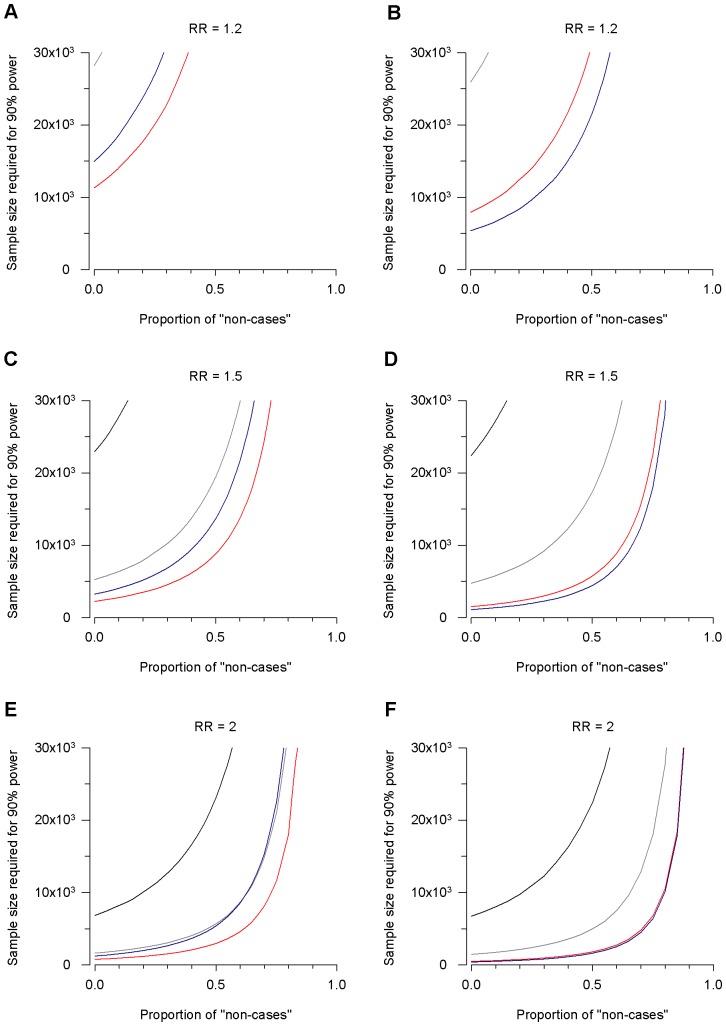
The impact of heterogeneity on the sample size (cases and controls) required for 90% of statistical power.The minimum sample size to achieve to detect association was calculated in simulated case-control data with increasing proportion of “non-cases” considering a disease prevalence of 0.01. Data are reported for minor allele frequencies (MAF) of 0.01 (black), 0.05 (grey), 0.2 (red) and 0.5 (blue). The results are reported for dominant (panels A, C, and E) and multiplicative (panels B, D, and F) genetic models. RR = relative risk.